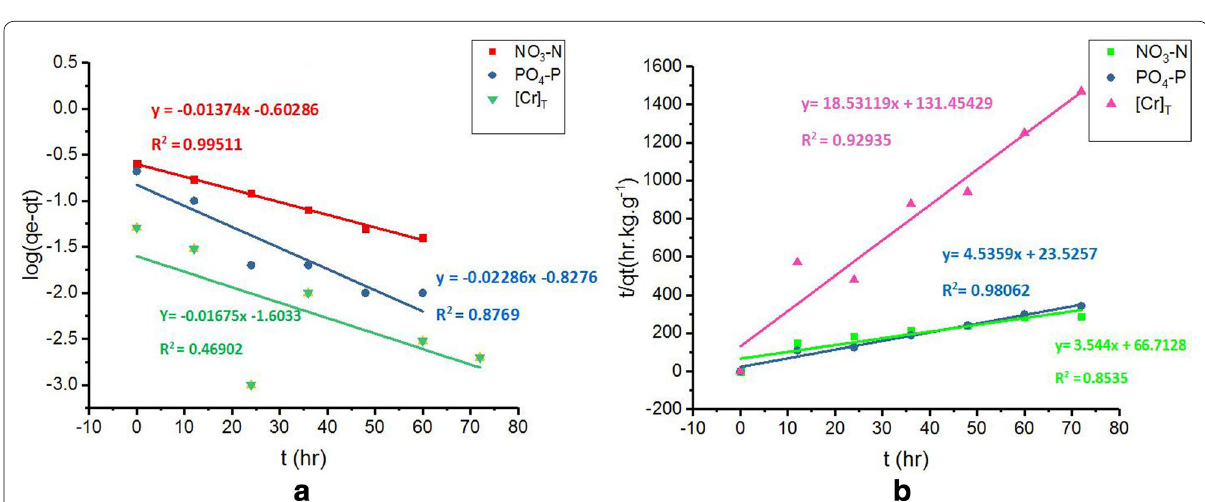
Fig. 6 a Pseudo-first-order kinetics. b Pseudo-second-order kinetics for the adsorption of NO 3 –N, PO 4 –P and [Cr] T removal onto